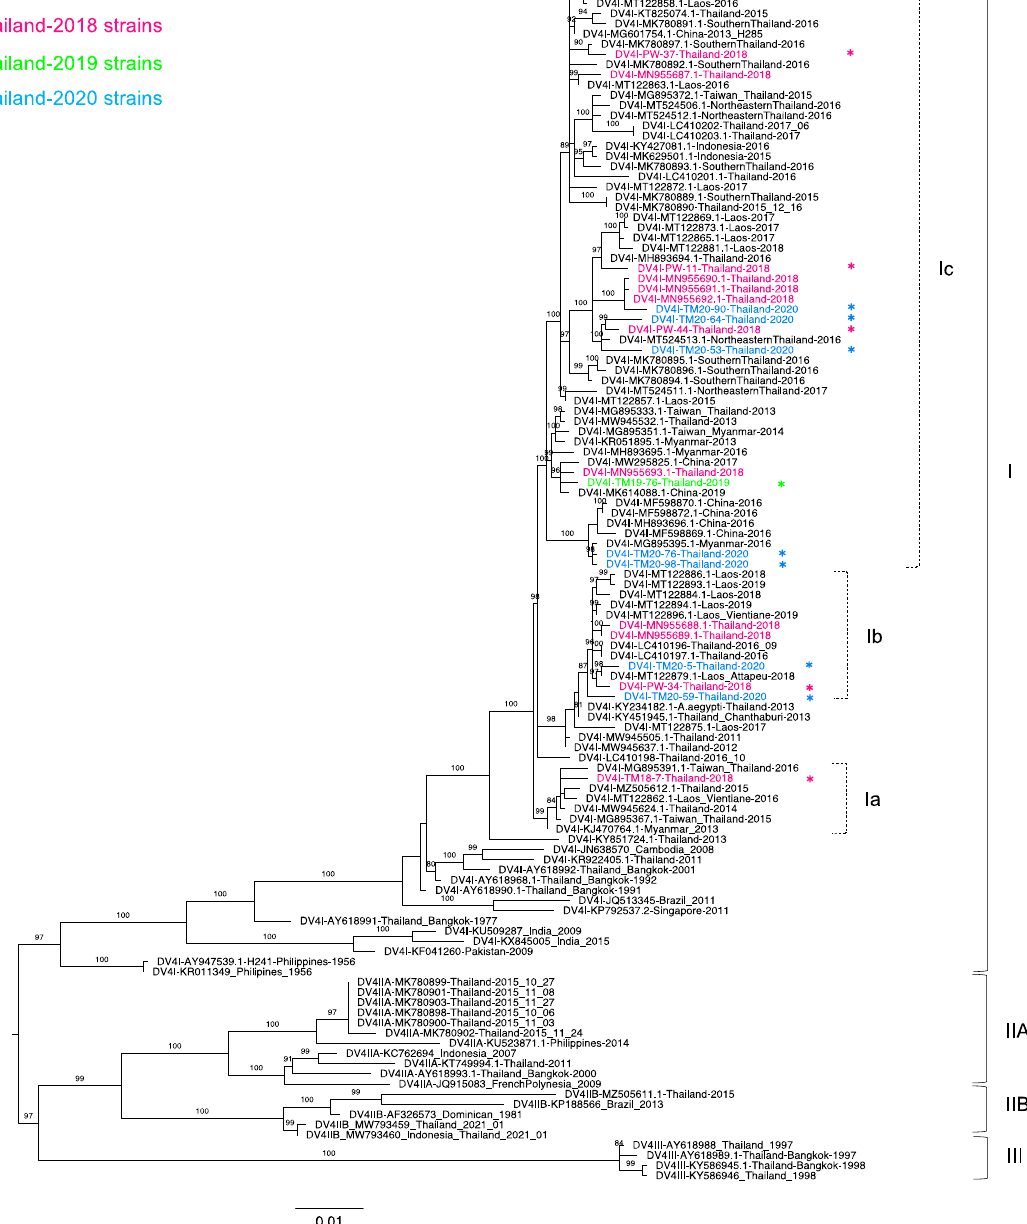
Figure 4. Phylogenetic analysis of Thailand DENV-4 in 2015–2020. The maximum-likelihood (ML) tree was constructed based on the complete envelope (E) gene sequences (1485 nucleotides) under TIM2 + F + G4 with 1000 ultrafast bootstrap replicates. The ML tree included 13 newly determined sequences of DENV-4 from clinical specimens from Bangkok in 2018–2020, their related strains, Thailand strains during 2015–2020, and the reference genotypes. The sequences collected in 2018, 2019, and 2020 are labeled in pink, green, and blue, respectively, and indicated in the upper left corner. The sequences newly determined in the present study are marked with asterisks (*). Viral genotypes and clades are indicated by black and dotted brackets, respectively, on the right. Sequences are shown by serotype, accession number, country, and reported year. Numbers on branches are bootstrap support values exceeding